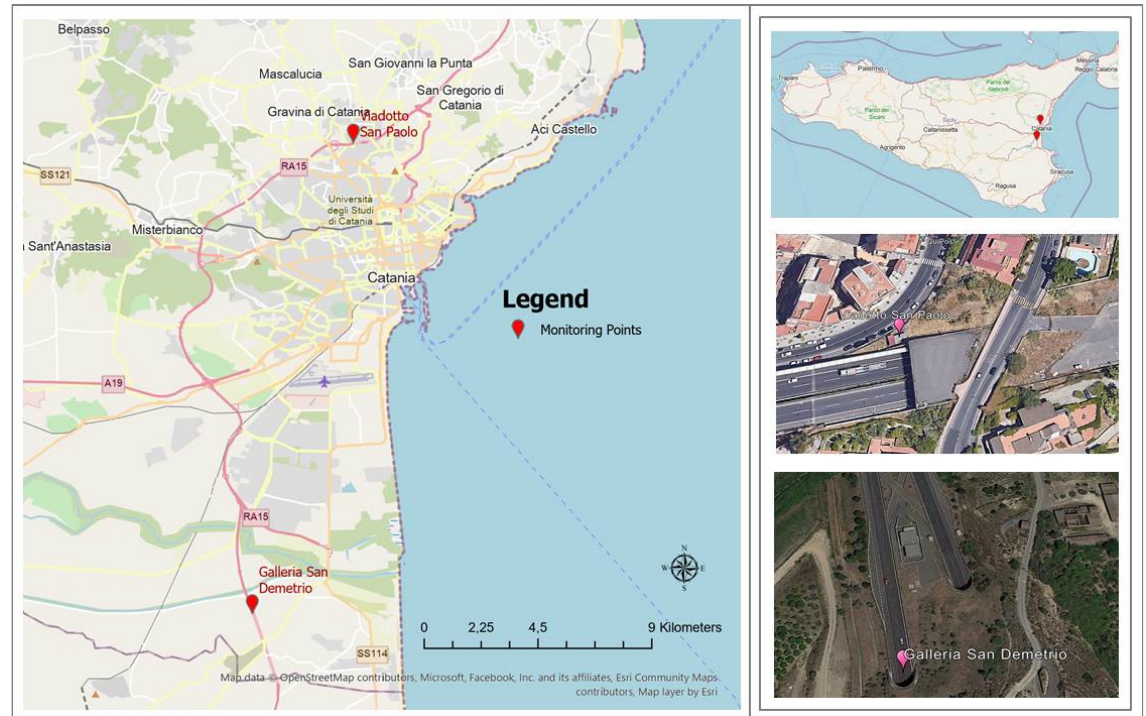
Figure 2. Map of the Catania-Siracusa RA15 highway (right), where the measuring stations on the viaduct (viadotto San Paolo) and in the tunnel (Galleria San Demetrio) are shown. On the bottom left, an air map Google photo of the tunnel San Demetrio (latitude: 37.36084, longitude: 15.0474463) and of the viadotto San Paolo (latitude: 37.36084, longitude: 15.0474463), both in the Siracusa direction, are shown. (Last accessed 27 December 2022).